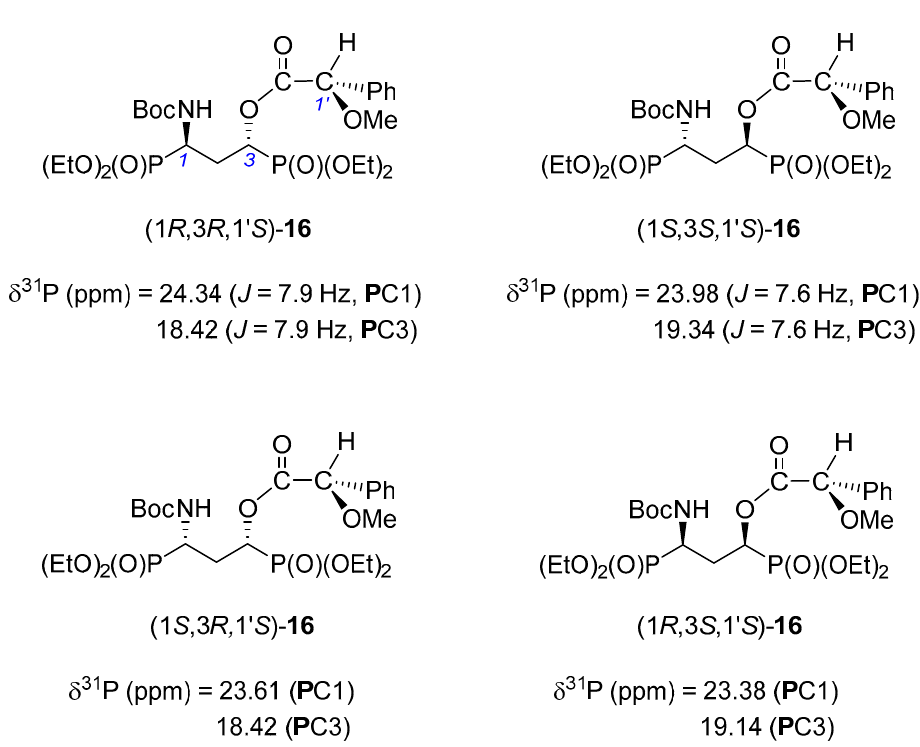
Figure 3. Structures of diastereoisomeric ( S )- O -methylmandelates 16 .